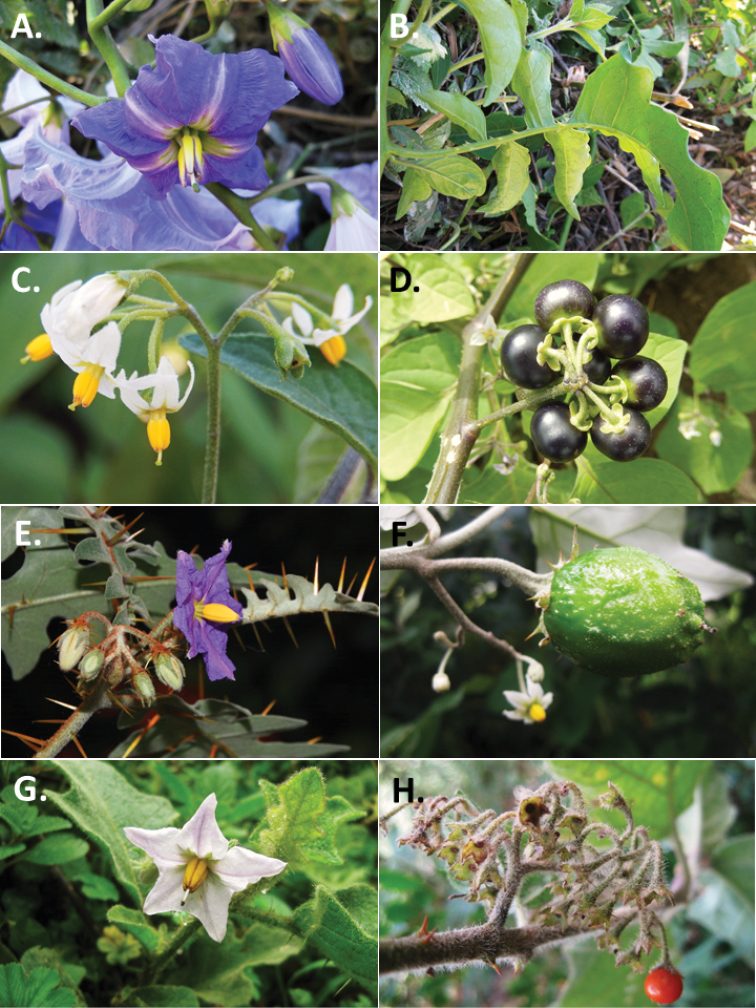
A, BSolanumwendlandii Hook.f. (Allophyllum-Wendlandii Clade) CSolanumtarderemotum Bitter (Morelloid Clade) DSolanumscabrum Mill. (Morelloid Clade) ESolanumpyracanthos Lam. (Leptostemonum Clade) FSolanumaculeastrum Dunal (Leptostemonum Clade) GSolanumnigriviolaceum Bitter (Leptostemonum Clade) HSolanumusambarense Bitter & Dammer (Leptostemonum Clade). Photos A, B, F, G H by M.S. Vorontosova C, D, E by S. Knapp.